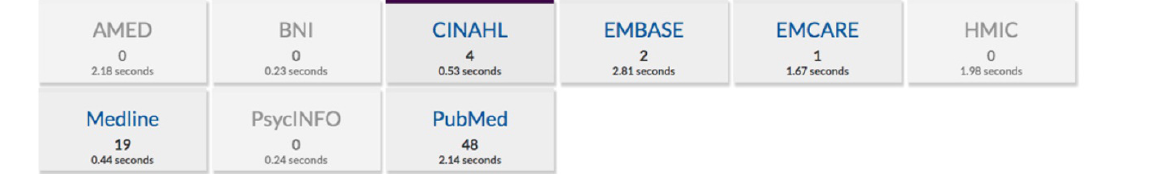
Figure 1. The results of the literature search.